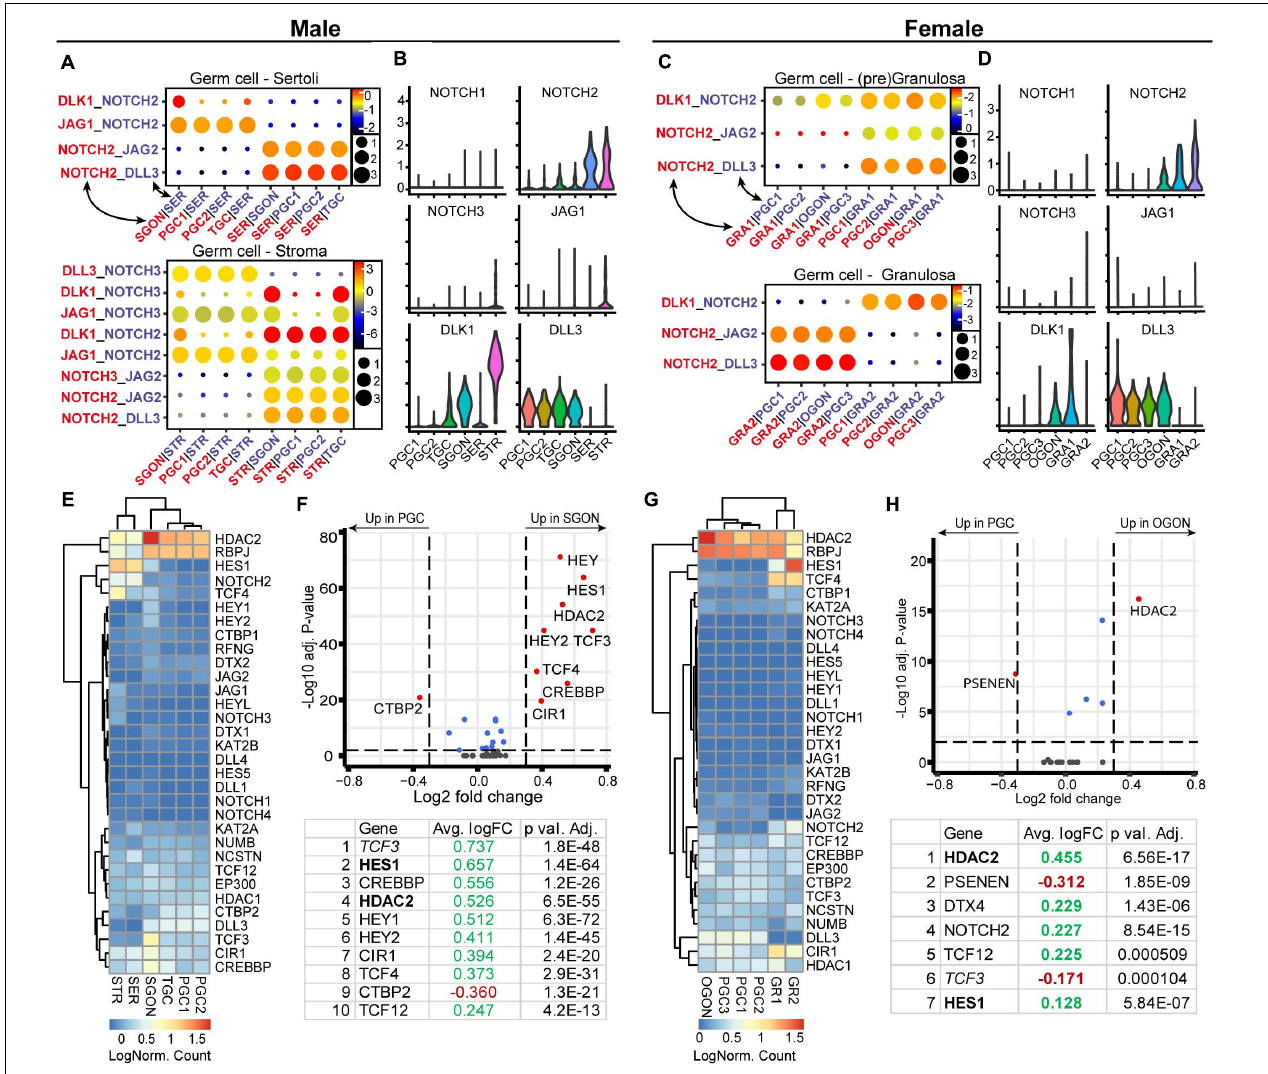
FIGURE 9 | Expression of NOTCH ligand–receptor pairs and downstream pathway effectors in fetal gonads. (A) CellphoneDB analysis of NOTCH interactions between different clusters in male fetal gonads. Circle size represents the − log 10 ( p -value). Depicted are − log 10 p -values (circle size) and log 2 means (circle color) for the interacting pairs, for selected pairwise cluster combinations. (B) Violin plots of selected NOTCH receptors and ligands in male germ and somatic clusters. (C) CellphoneDB analysis of NOTCH interactions between different clusters in female fetal gonads. (D) Violin plots of selected NOTCH receptors and ligands in female germ- and somatic clusters. (E) Heatmap showing the expression of genes of interest associated with NOTCH signaling pathway in male germ and somatic cell clusters. (F) A volcano plot showing NOTCH-related genes between PGC and GON clusters in male gonads. Table shows the top 10 differentially expressed genes. Genes in bold are common between male and female, while genes in italics show divergent regulation. (G) Heatmap showing the expression of genes of interest associated with NOTCH signaling pathway in female germ and somatic cell clusters. (H) A volcano plot showing NOTCH-related genes between PGC and GON clusters in female gonads. Table shows the top seven differentially expressed